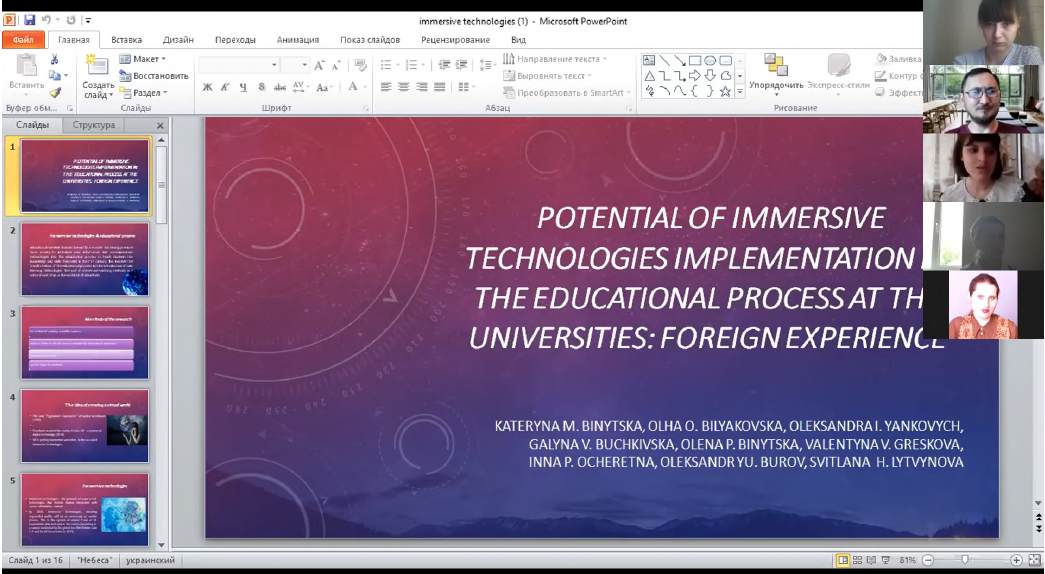
Figure 100: Presentation of paper